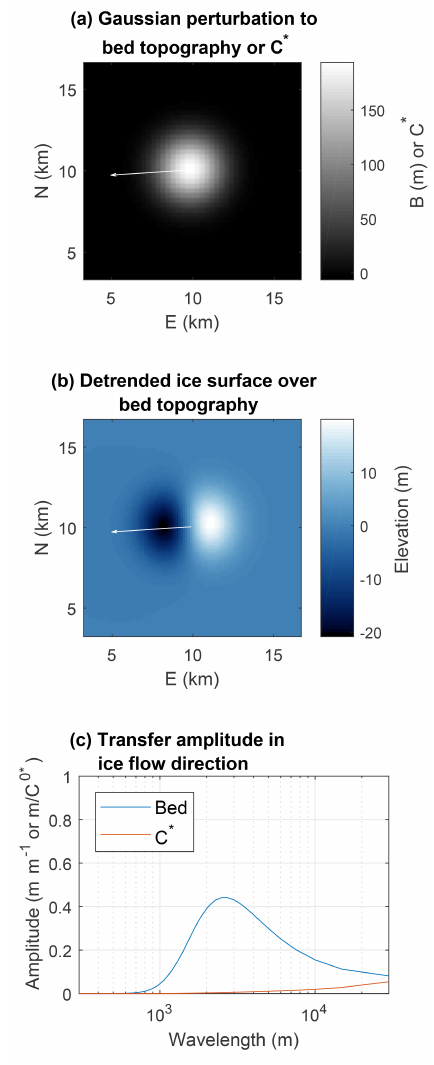
Figure 4. Illustration of steady-state basal transfer for ice flow pa- rameters representative of the western Greenland ablation zone. Ice flow parameters are from region R1 (Fig. 1a, Table 1) with η = 10 14 Pas. (a) Gaussian bed topography or basal sliding per- turbation. (b) Detrended predicted ice surface over the Gaussian bed topography perturbation (with C 0 ∗ = 10). White arrows in (a) and (b) indicate the ice flow direction. (c) Transfer amplitudes in the ice flow direction (along a flow line) for bed topography and basal sliding C ∗ perturbations. The transfer functions also have important phase components not shown here (see Gudmundsson, 2003). With these flow parameters, surface topography created from basal slid- ing perturbations should generally be of much lower amplitude than surface topography created from bed